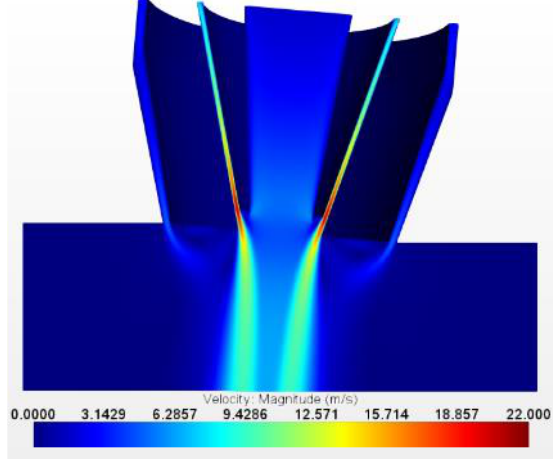
Figure 10: Simulation using condition E